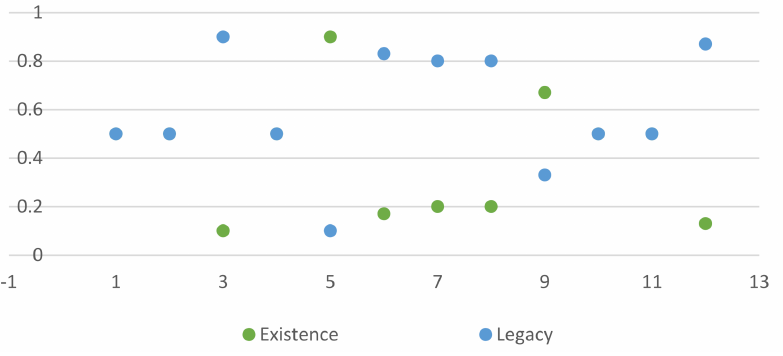
Figure 10. Individual preference weights for non-use